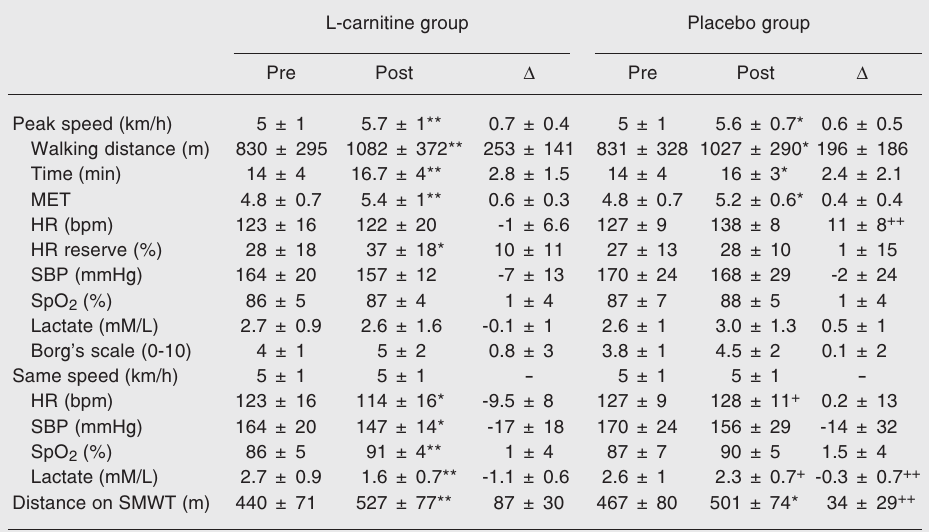
Table 3. Effect of L-carnitine supplementation associated with exercise training on peak exercise and physiological responses at identical levels of exercise. L-carnitine group Placebo group